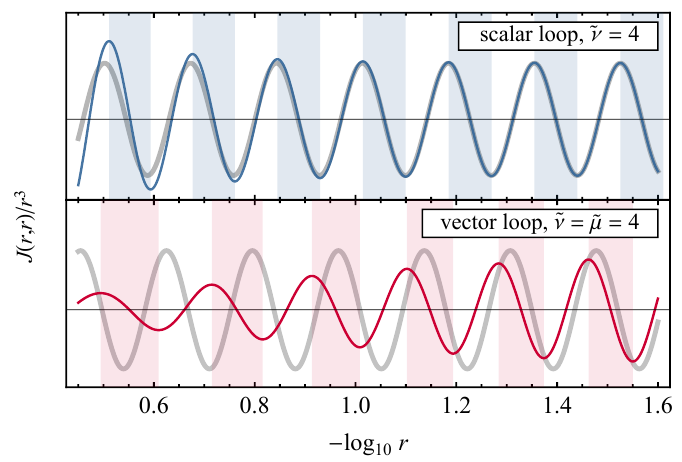
Figure 1 . Two samples of nonlocal CC signals in the 4-point function, from a scalar loop (upper) and a vector loop with chemical potential enhancement (lower). The colored curves show the complete results for nonlocal signals, while the light gray curves show the squeezed limit